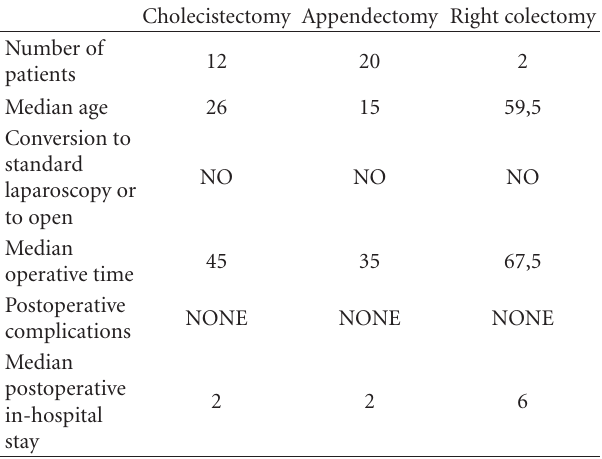
Table 1: Patients and perioperative